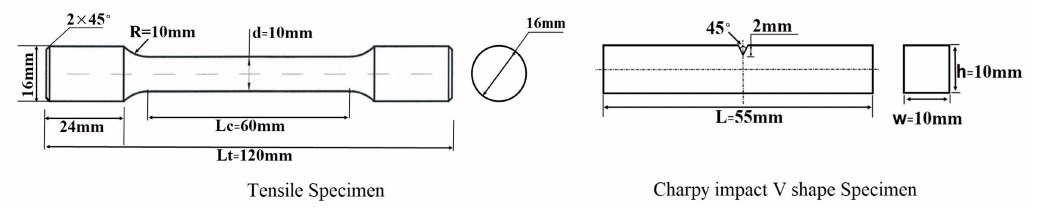
Figure 2. Dimensions of the tensile specimen and impact